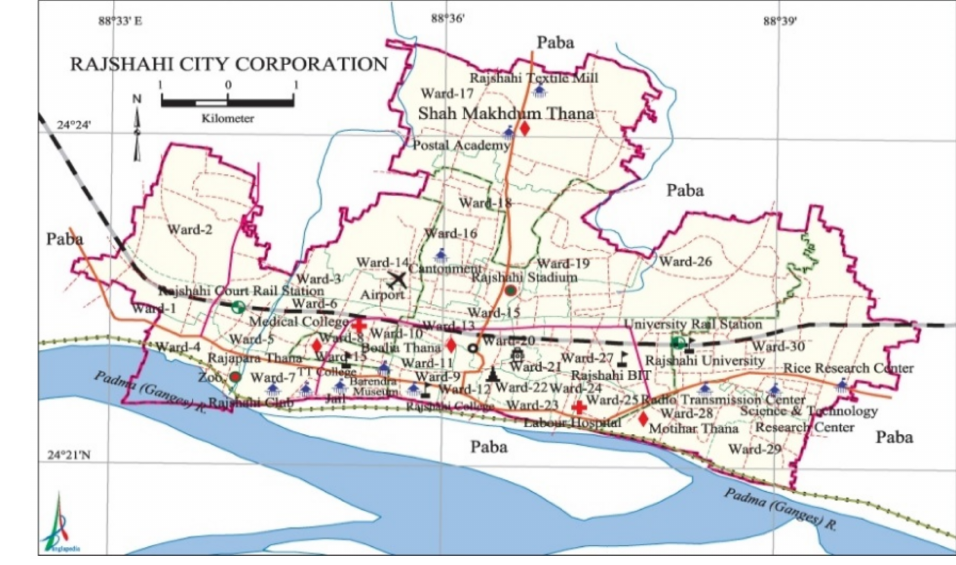
Figure 3. Layout of Rajshahi City Corporation [21]. Table 1. Contribution of different sources to MSW generation in all major cities